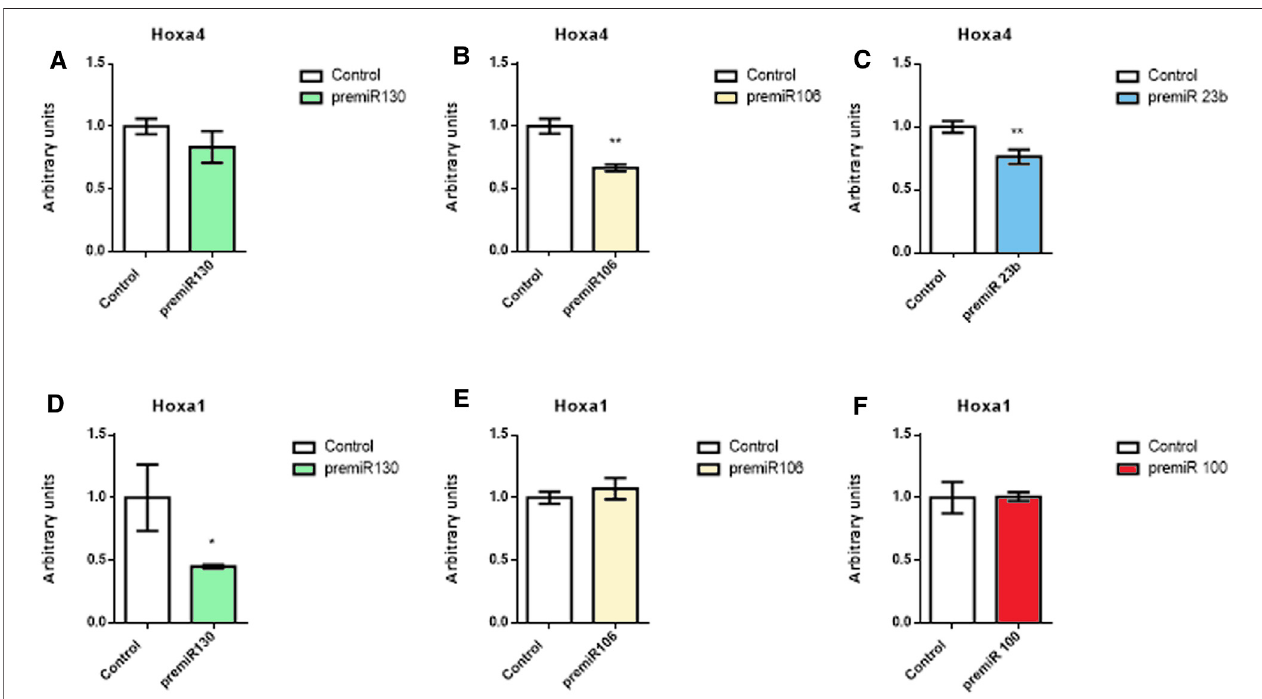
FIGURE 7 | Dual luciferase assays. Representative data of Hoxa4 (A – C) and Hoxa1 (D – F) 3 ′ UTR luciferase assays after miR-130a, miR-106a, miR-23b, and miR-100 overexpression in 3T3 fi broblasts. Student ’ s t -test: * p < 0.05, ** p < 0.01, *** p < 0.005, **** p < 0.001.